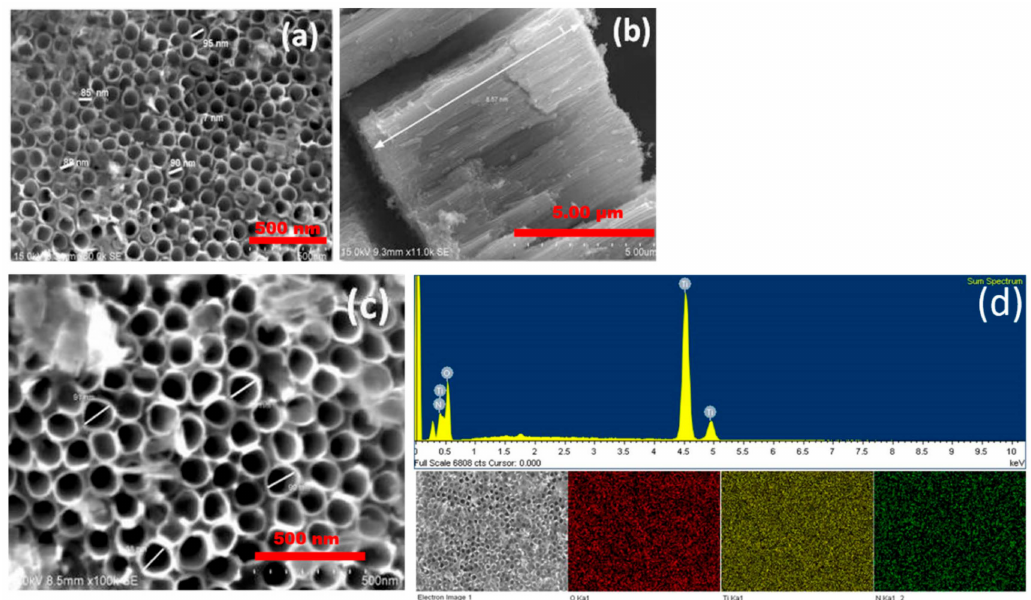
Figure 3. Field emission scanning electron microscopy (FESEM) micrograph of ( a ) top view-TiO 2 nanotubes, ( b ) cross sectional view-TiO 2 nanotubes, ( c ) top–view-N-TiO 2 nanotubes and ( d ) energy dispersive spectroscopy (EDS) of N-TiO 2